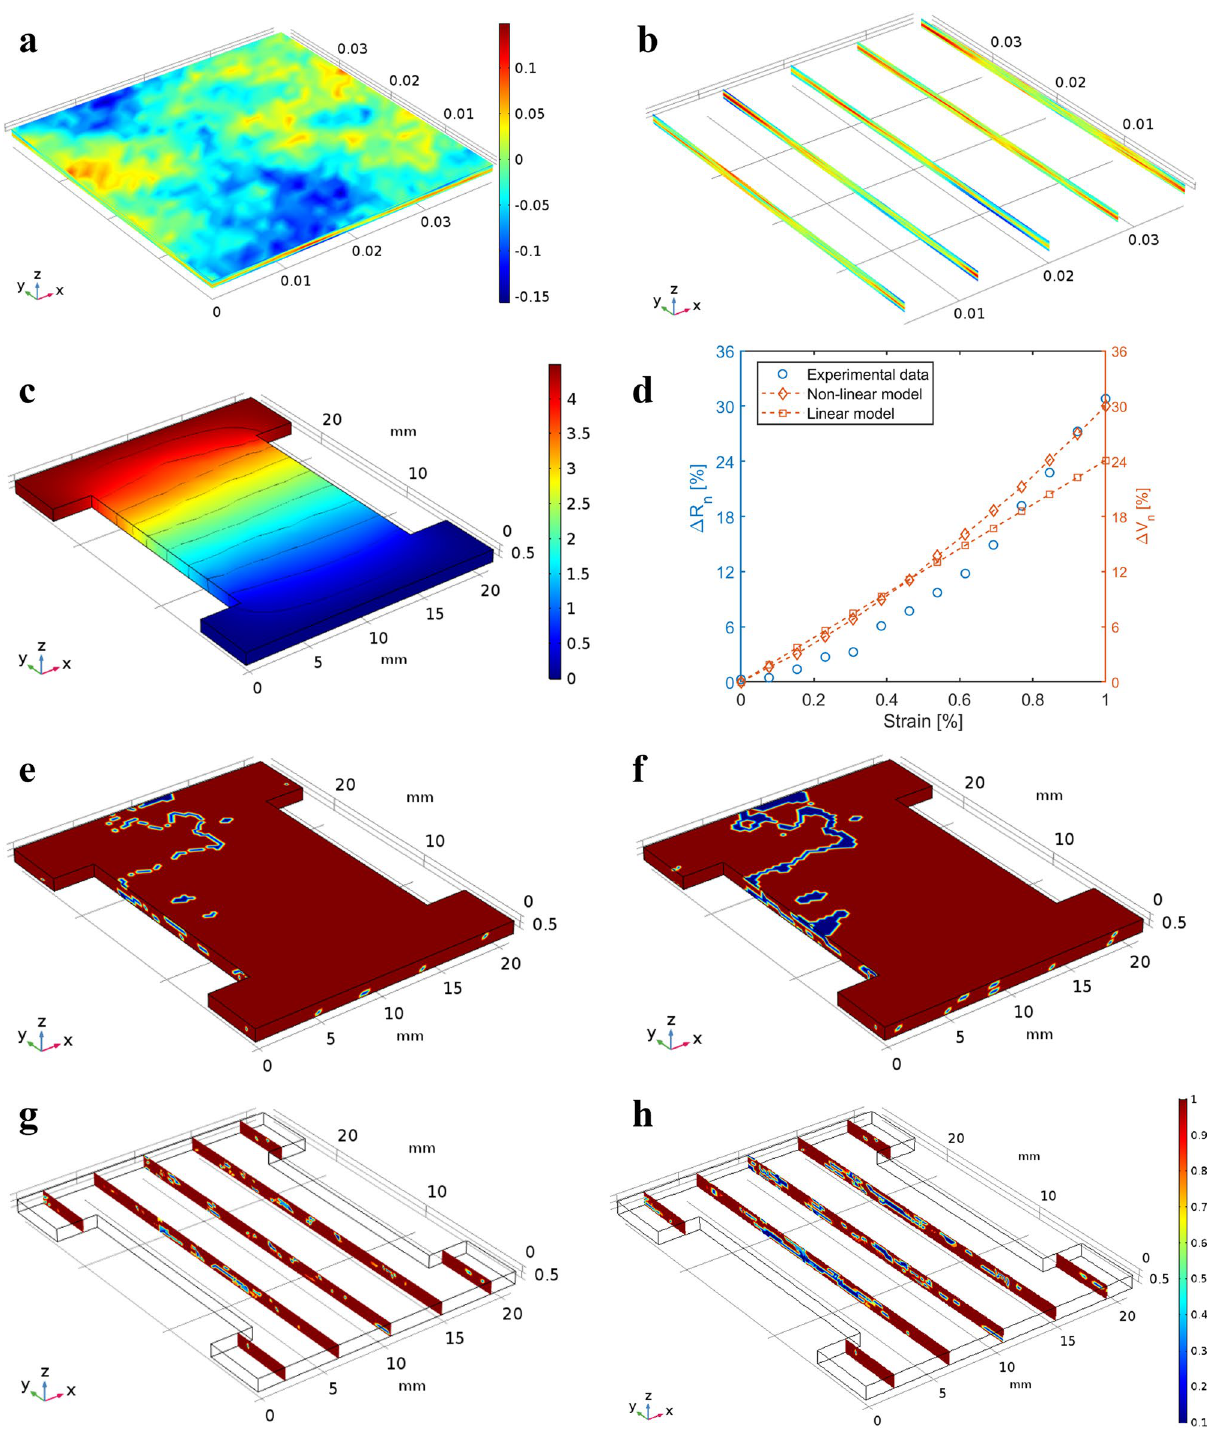
Figure 4. Percolated inhomogeneous material models. ( a ) The synthesized randomized data distribution in the thin slab. ( b ) Randomized data distributions on five slices on the y–z plane within the thin slab. ( c ) The FE model was calibrated using experimental results of the Non-Patterned GNS-EC nanocomposites, and ΔV n with respect to applied strains are compared to the experimentally measured ΔR n values. ( d ) The non-linear FE model was calibrated using experimental results from the Non-Patterned topology, and ΔV n with respect to applied strains are compared to the experimentally measured ΔR n values as well as that obtained from the linear model. ( e , f ) The electrical conductivity distributions in the Non-Patterned material model when it was subjected to 0.5% and 1% tensile strains along the y-axis, respectively. ( g , h ) Five cross-sections of the electrical conductivity distributions in ( e ) and ( f ), respectively. ( e – h ) Share the same color